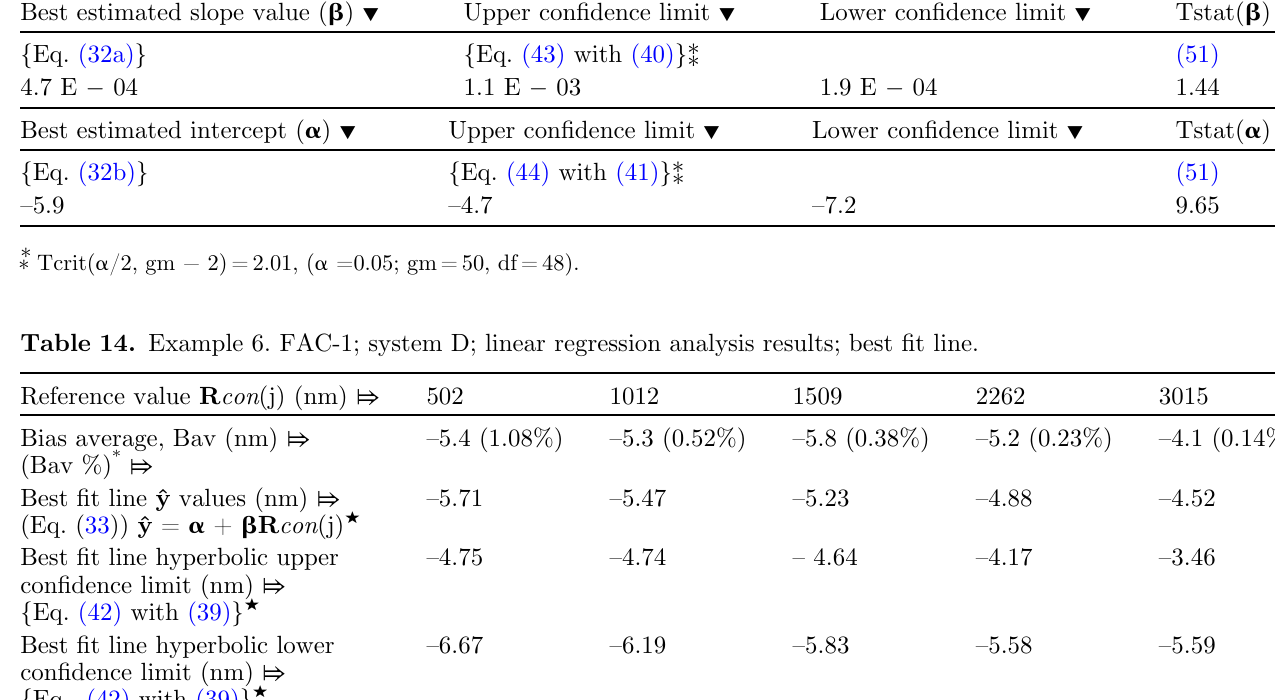
Table 13. Example 6. FAC-1; system D; linear regression analysis results; slope & intercept. Best estimated slope value ( b ) ▾